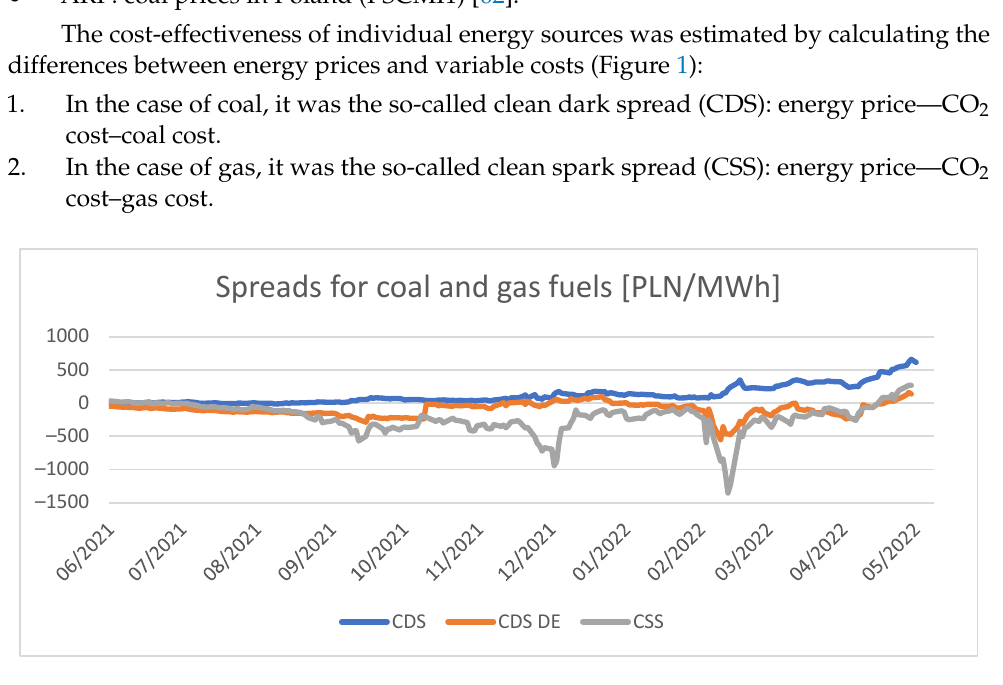
Figure 1. Historical CSS and CDS for Poland and Germany (source: created by authors in 2022).